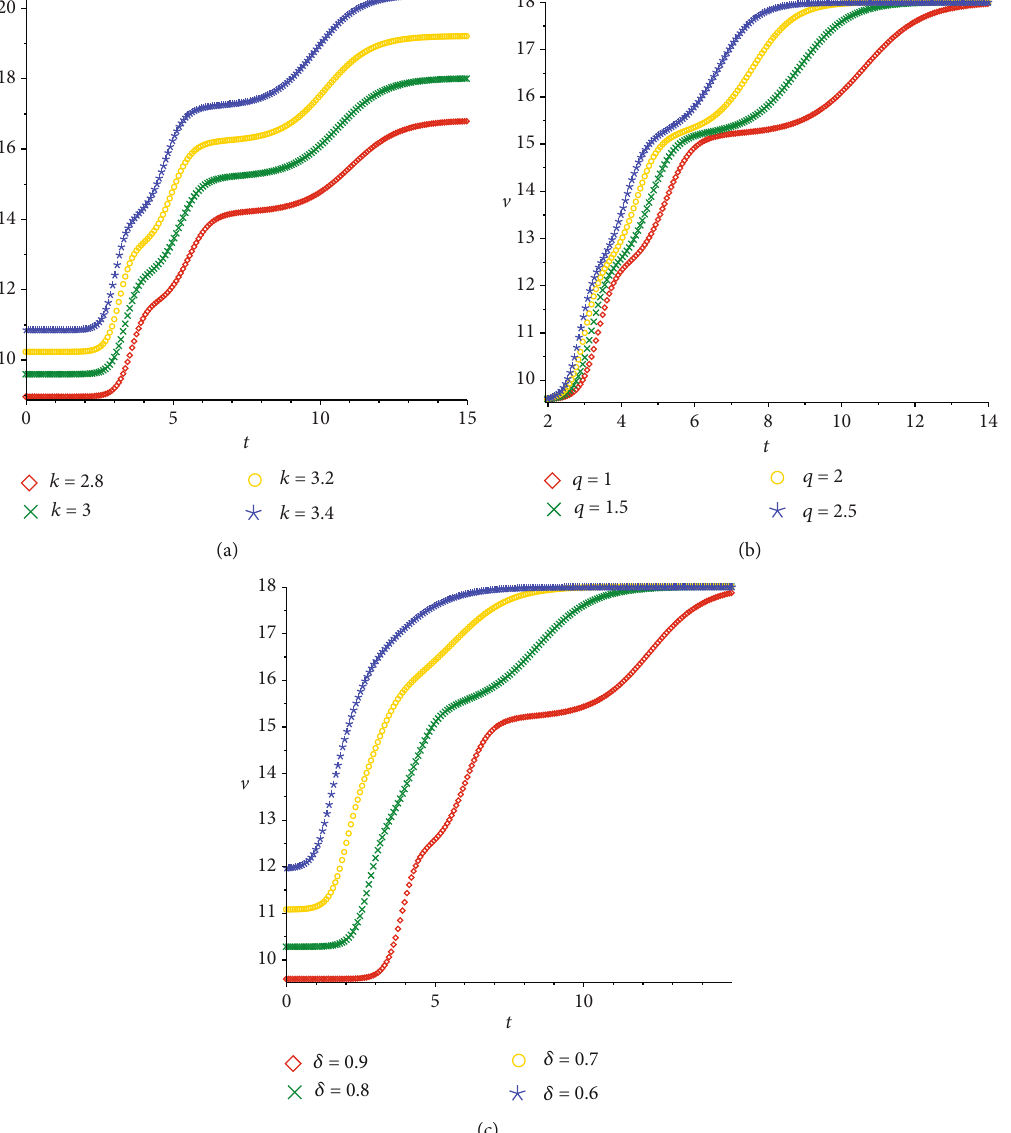
= 1, l = 0 : 5, l = 1 : 5 : (a) q = 1, δ = 0 : 9 , (b) k = 3, δ = 0 : 9 , K = 3 , q = 1 , and (c) q = 1, k = 3 at x = 40 1 2 3